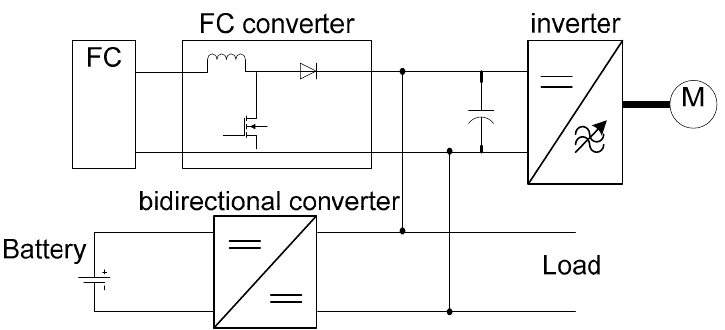
Figure 1. Fuel cells and batteries hybrid system on ZemShip.